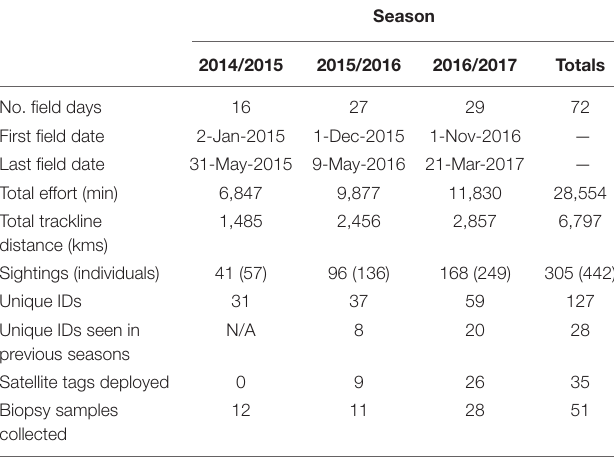
TABLE 1 | Summary of field effort and humpback whales sighted, photo-identified, satellite-tagged, and biopsied over three consecutive field seasons from 2015 to